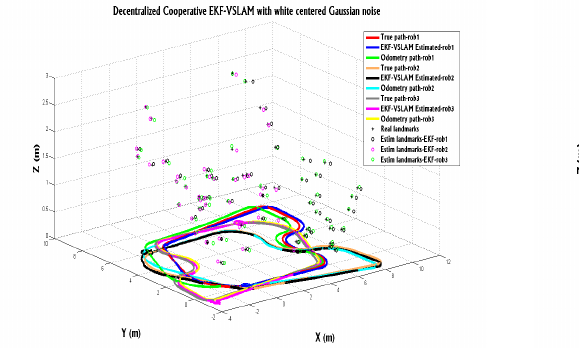
Fig. 4: Visual EKF-SLAM simulation results with white centered Gaussian noise.